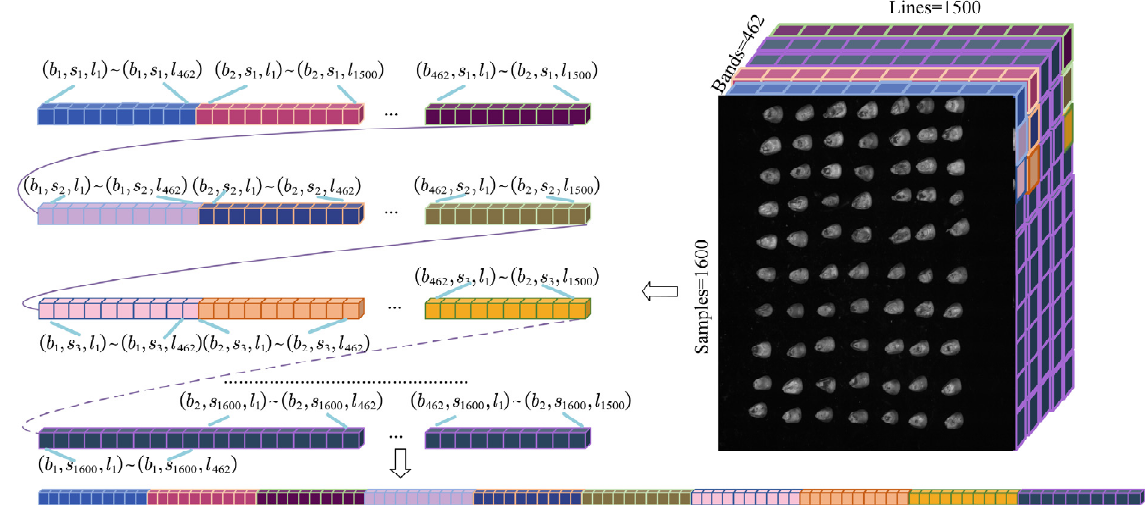
Figure 3. Hyperspectral image processing and curves.